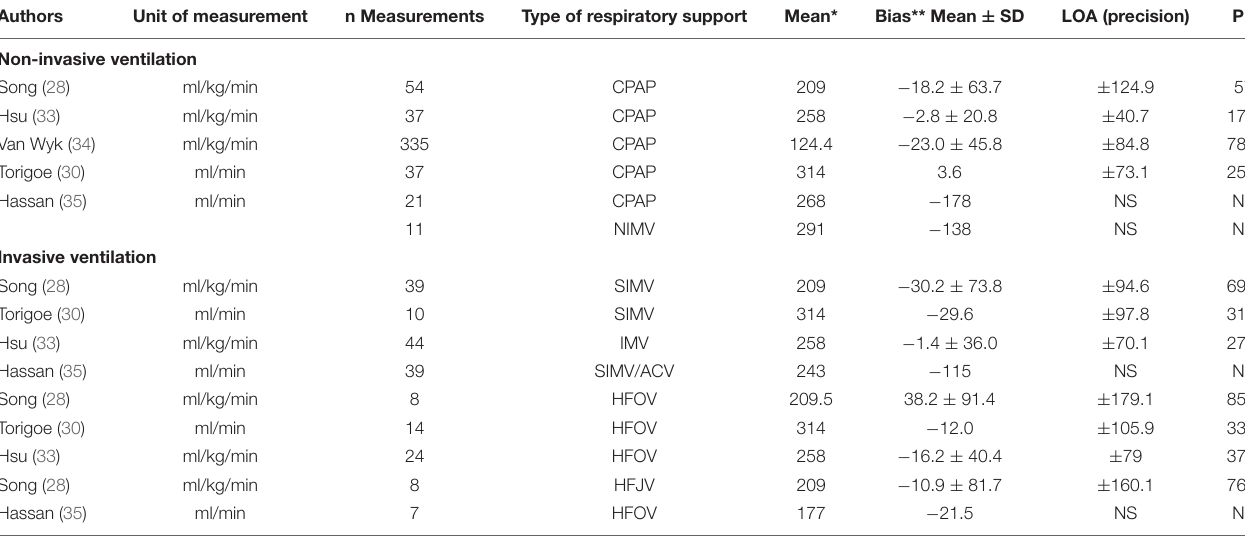
TABLE 5 | Accuracy and precision in studies with different respiratory support